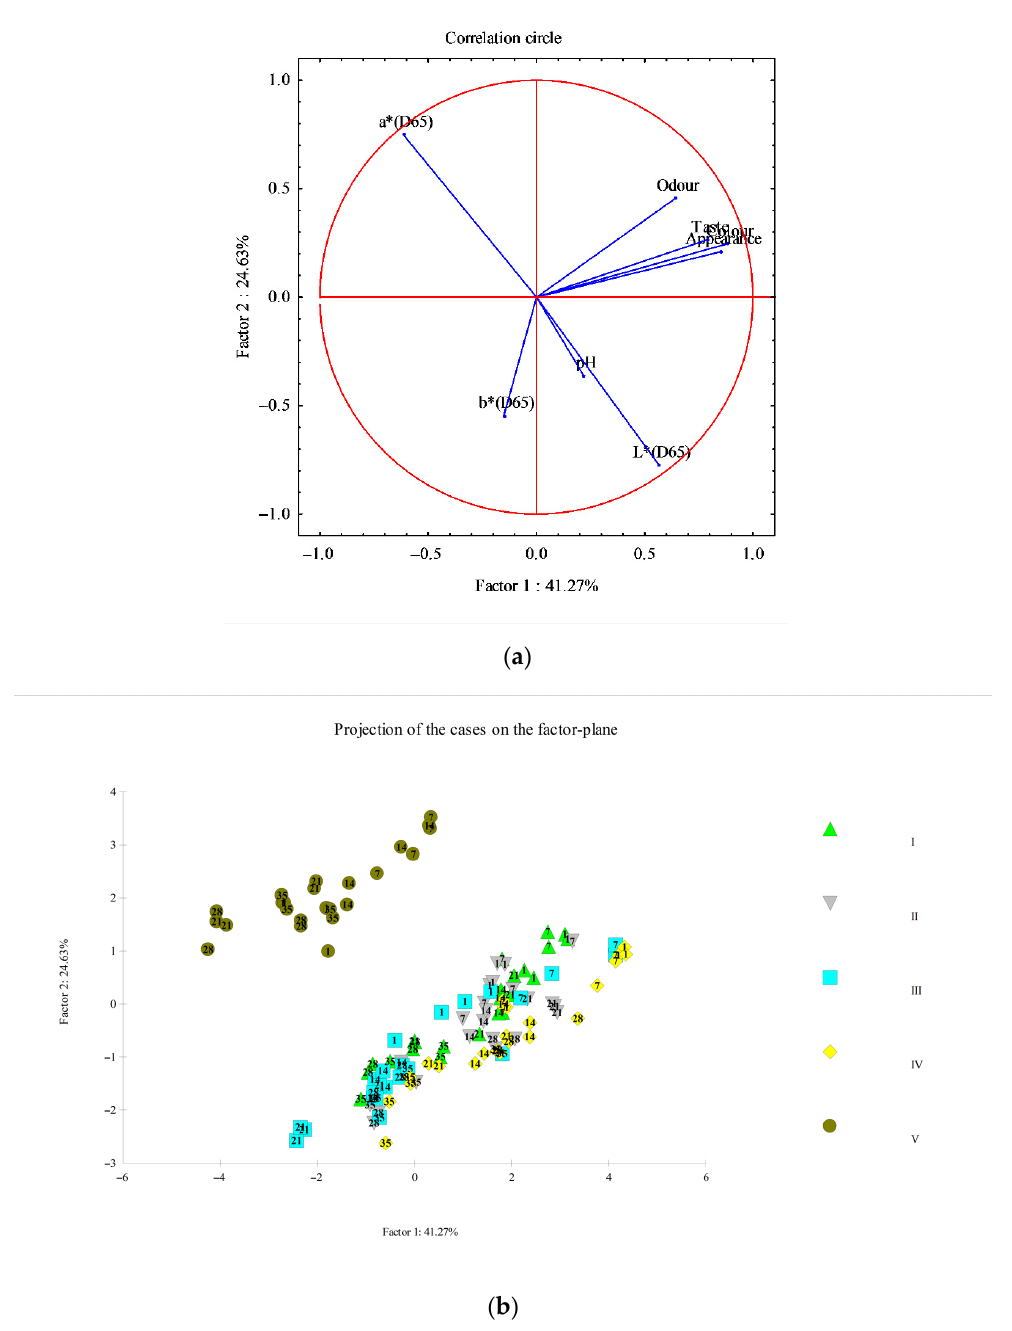
Figure 6. Principal component analysis obtained from the correlation of eight components (sensorial analysis, pH, and color) and 120 cases, determined in the smoked fillets D. labrax . ( a ) Correlation circle; ( b ) Factor-plan. In Figure 6b, different symbols, from I to V, indicate the smoking cycles.